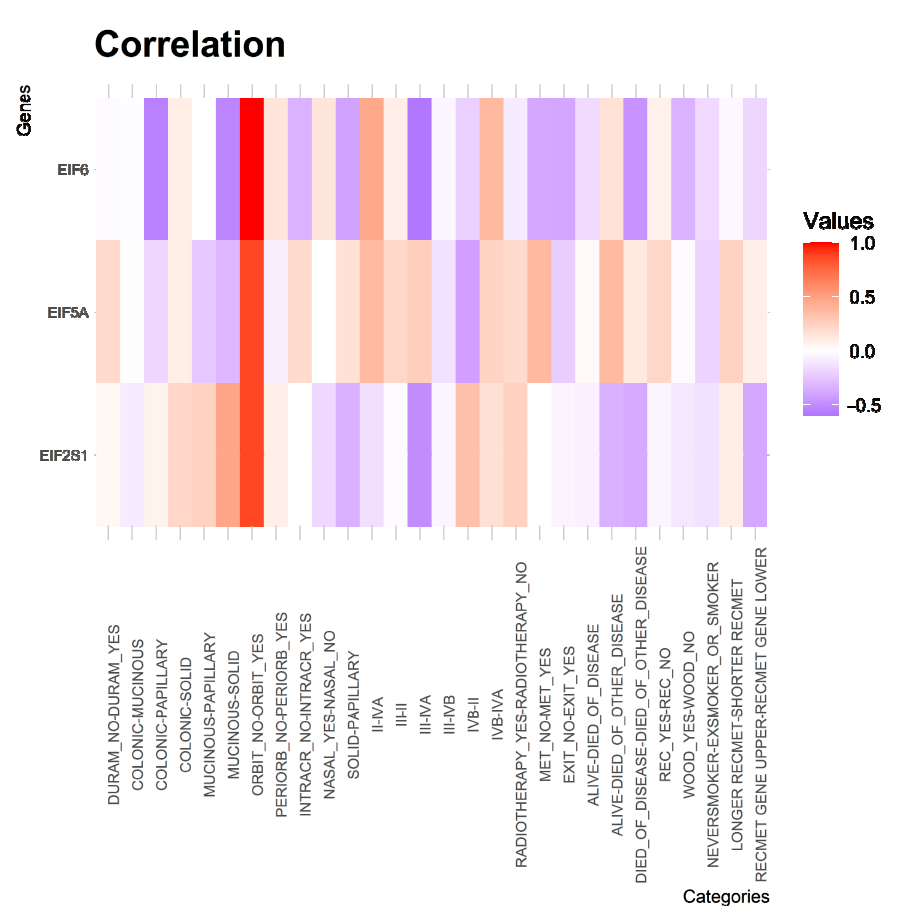
Figure 5. Spearman correlations between groups and the translation factors EIF2S1, EIF5A and EIF6. The groups are based on clinical information. The scores of each eIF from the first group was correlated with the scores of the second group. For ‘RecMet gene upper-RecMet gene lower’ the recurrence time of the group with the higher scores was used (median split) and was correlated with the group with the lower scores for each eIF. EIF6 revealed a high negative correlation (rho < − 0.4) between stage III and stage IVA (Wilcoxon p -value = 0.1425), between died of disease versus died of other disease ( p = 0.8980) and between the subtypes colonic and papillary, between mucinous and solid ( p = 0.2273) and between solid versus papillary. Moderate anticorrelations (rho < − 0.2) were obtained after comparisons between no occurrence of death and between the occurrence of death ( p = 0.4562), between the presence and the absence of metastases ( p = 0.9934), between a spread to the intercranial space and no spread to the intercranial space ( p = 0.7835) and between an exposure to hardwood dust and no exposure ( p = 0.8227). Mild anticorrelations (rho < − 0.1) were found between stage IVB and stage II ( p = 0.5818), be- tween an upper–lower dichotomization of time to recurrence or metastasis ( p < 0.000),